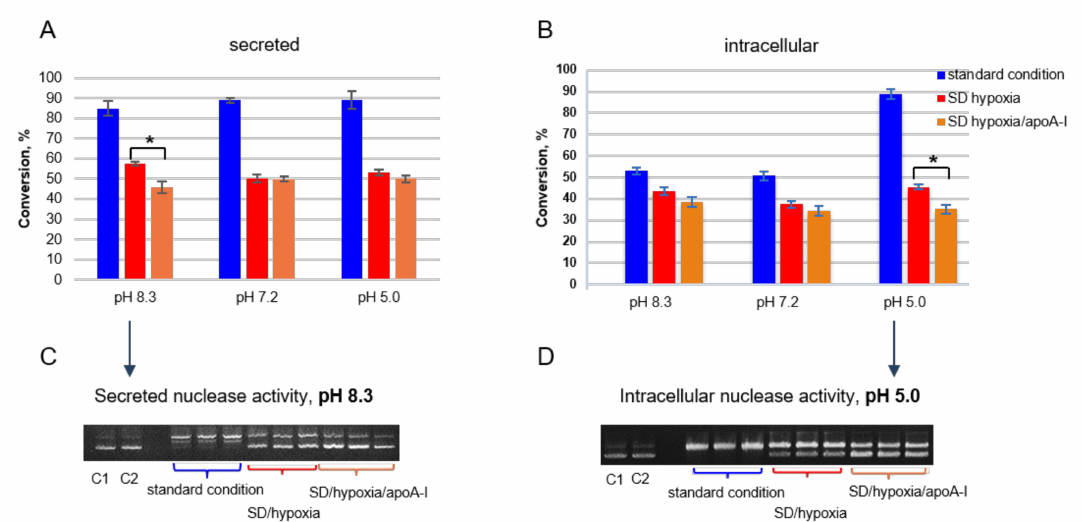
Figure 3. Percent of conversion of supercoiled plasmid DNA (pDNA Bluescript) into nicked species. Nuclease activity estimated from ( A ) homogenized MSCs (intracellular activity) and ( B ) culture medium (secreted activity). * p ≤ 0.01. ( C ) 0.8% agarose gel illustrating the secreted nuclease activity, pH 8.3. ( D ) 0.8% agarose gel illustrating the intracellular nuclease activity, pH 5.0. C1—control 1-whole pDNA, C2—control 2-pDNA / cells (for intracellular) or media (for secreted) / EDTA. Samples were studied in triplicate. Full gels electrophoregram is presented in Figure S1 (see Supplementary